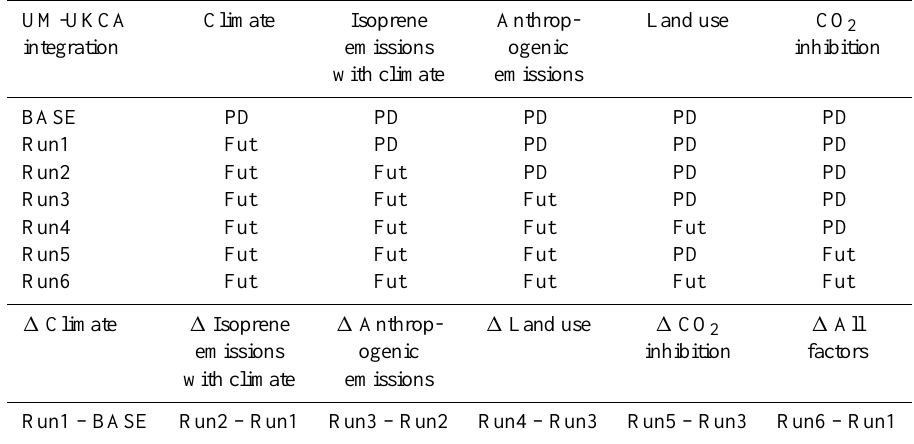
Table 1. Model integrations conducted with UM-UKCA (BASE and Runs 1–6). PD=present-day (2000), Fut=Future (2095). The lower section of the table indicates how changes due to each perturbation are calculated. UM-UKCA Climate Isoprene Anthrop- Land use